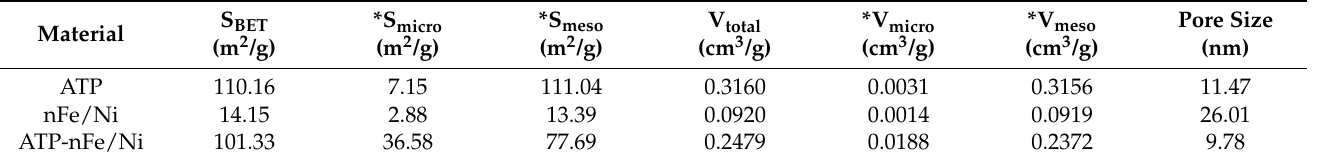
Table 1. BET specific surface area and pore parameters of ATP, nFe/Ni and